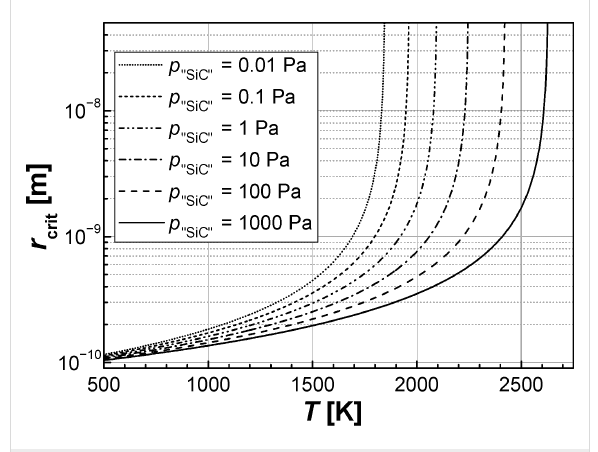
Figure 1: Calculated values for the smallest thermodynamically stable particle radius r crit at different partial pressures of gaseous "SiC" species, according to Equation